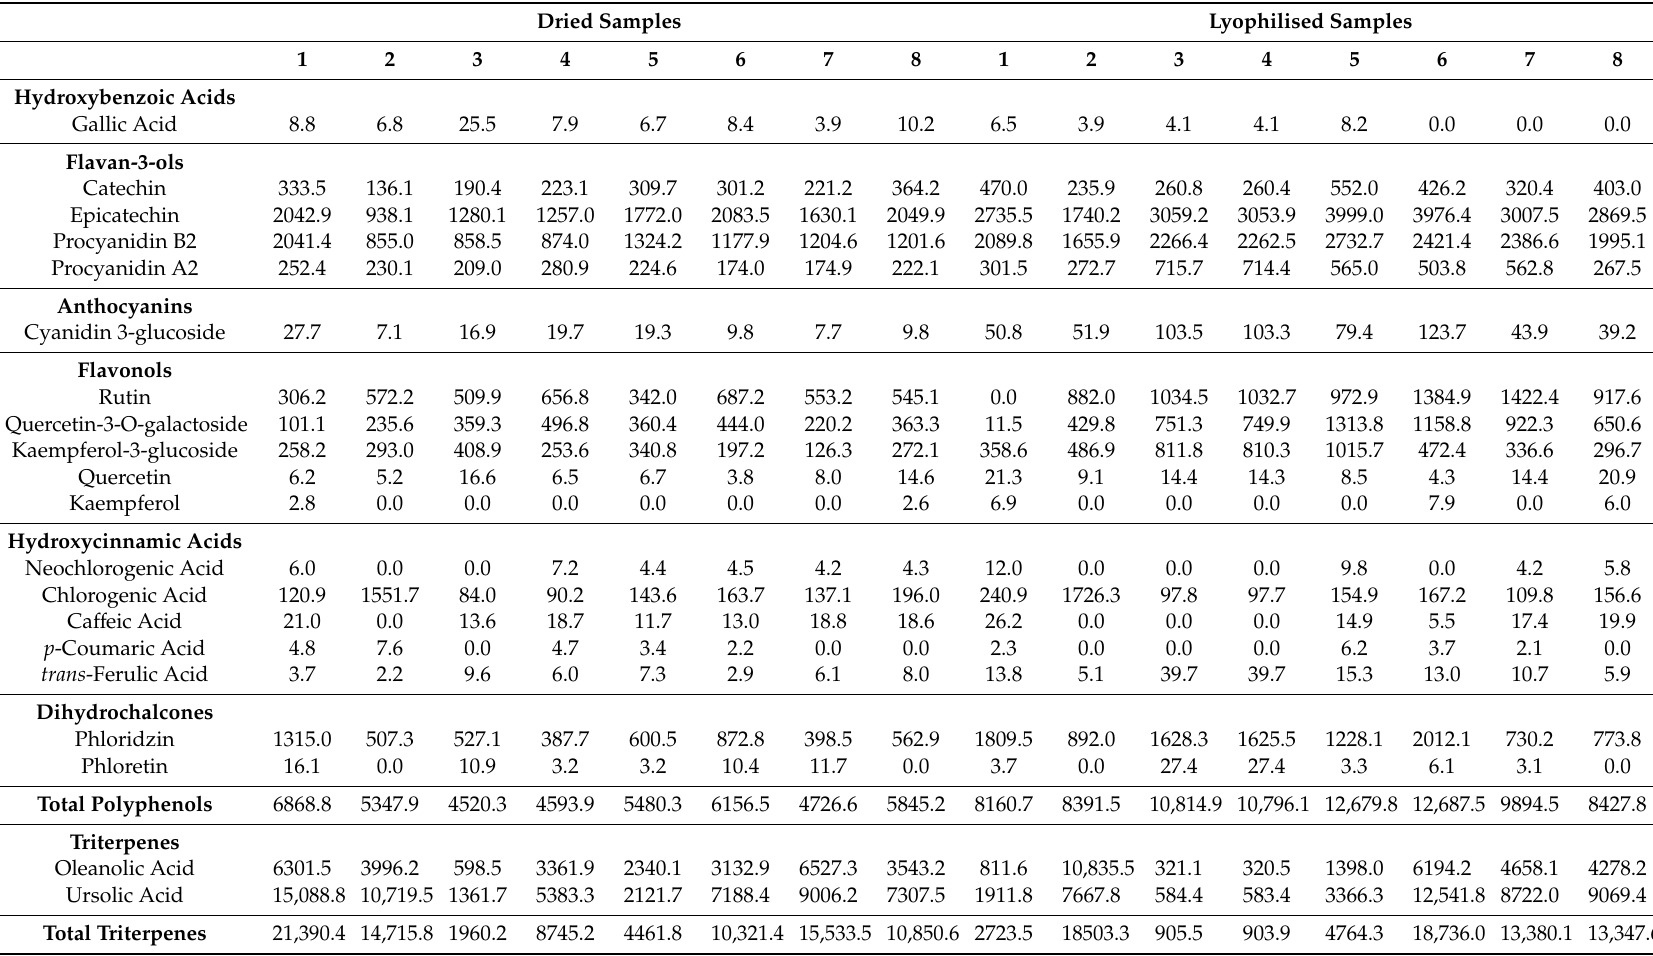
Table 1. Concentrations of phytochemicals, expressed in mg / kg, in the extracts obtained from the dried and lyophilized peel of Mela Rosa dei Monti Sibillini. Dried Samples Lyophilised